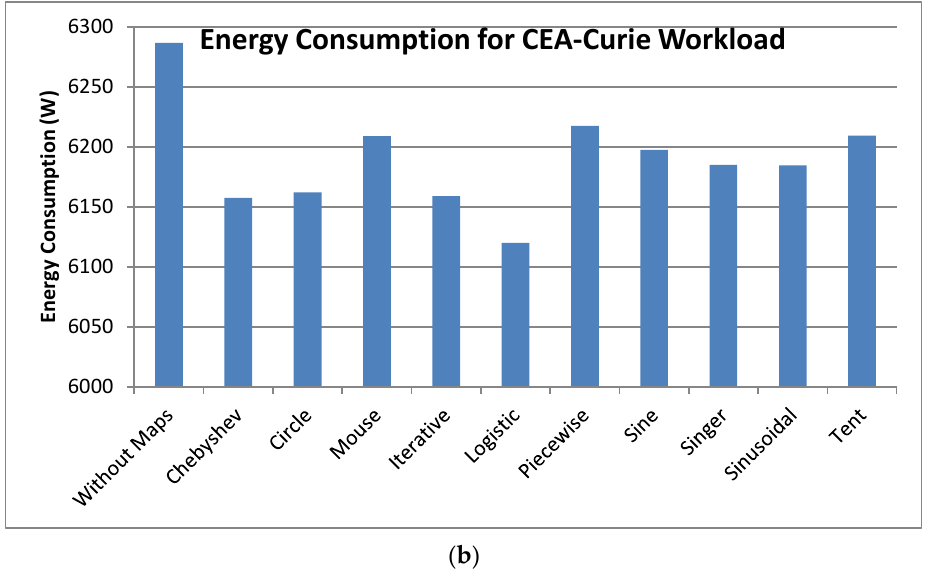
Figure 2. Performance of pilot experiments of h-DEWOA with chaotic maps for CEA-Curie workload: ( a ) Makespan; ( b ) Energy consumption.